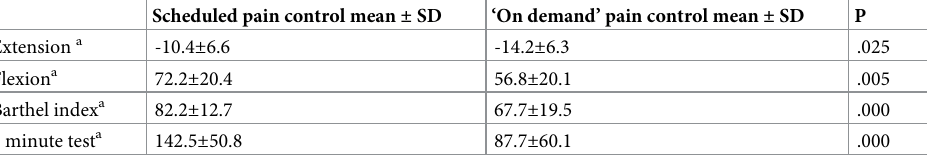
On POD5, all observed functional outcome measures, knee extension deficit and flexion, Barthel score, as well as 6 minute walking test were significantly better in the scheduled pain control group. The differences between the two treatment groups regarding early functional outcome were most pronounced with respect to ambulation. Patients in the group with sched- uled pain control group had a highly significant faster gait speed on POD5 as measured with the 6 minute walking test (see Table 4). At 3 months postoperatively, the KOOS subscales for pain, activities of daily living and quality of life were significantly better in the scheduled pain group (see Table 5). Table 4. Functional outcomes on